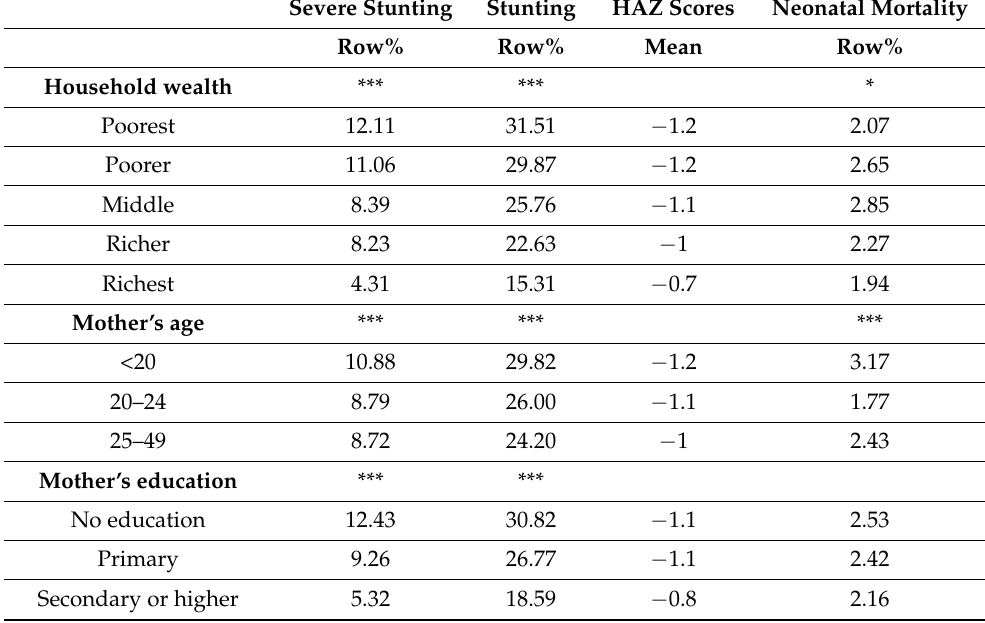
Table 4. Prevalence and mean of outcome variables by select